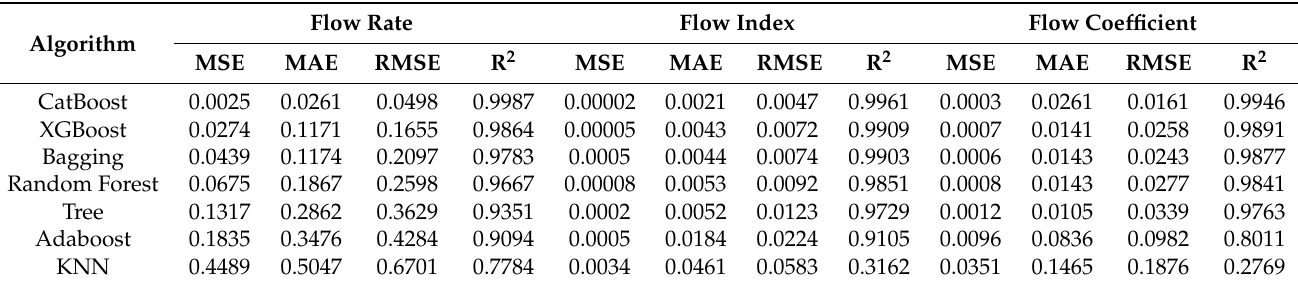
Table 4. Comparison of the accuracy of different models for predicting flow rate, flow index, and flow